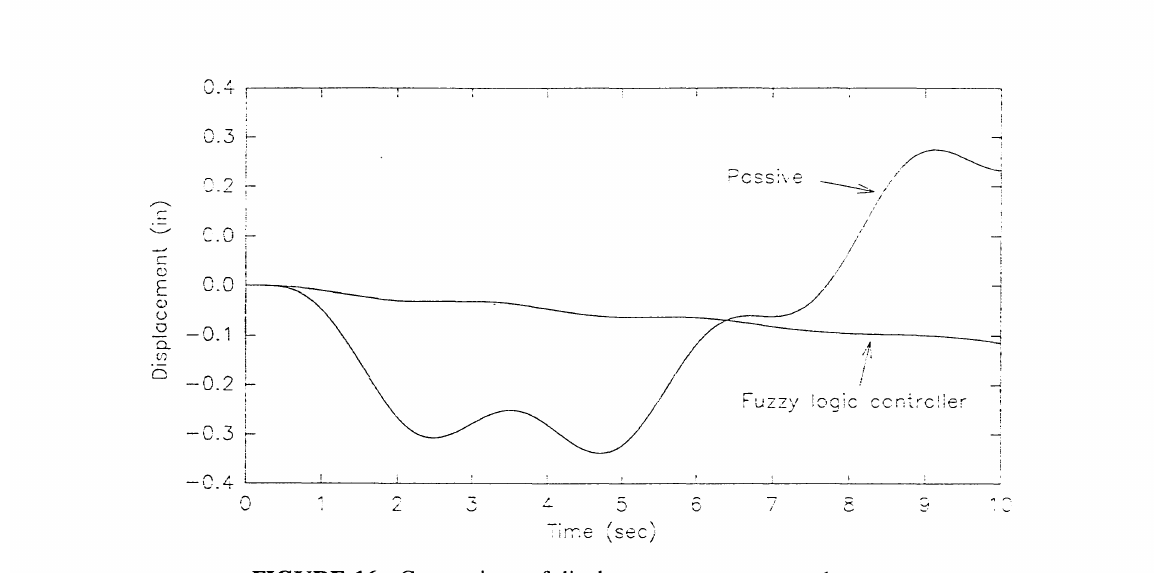
FIGURE 16 Comparison of displacement response at the